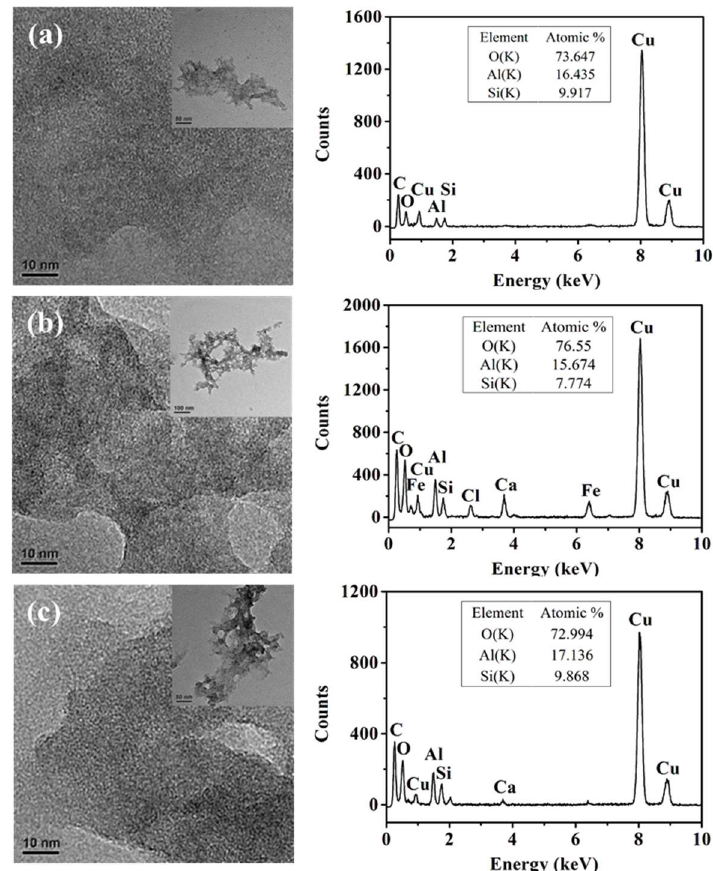
Figure 5. HRTEM images, SAED patterns, and EDS spectrums of wear debris when using different catalyzing modes: ( a ) pristine pad, ( b ) soft abrasive with high reactivity, and ( c ) citric acid.